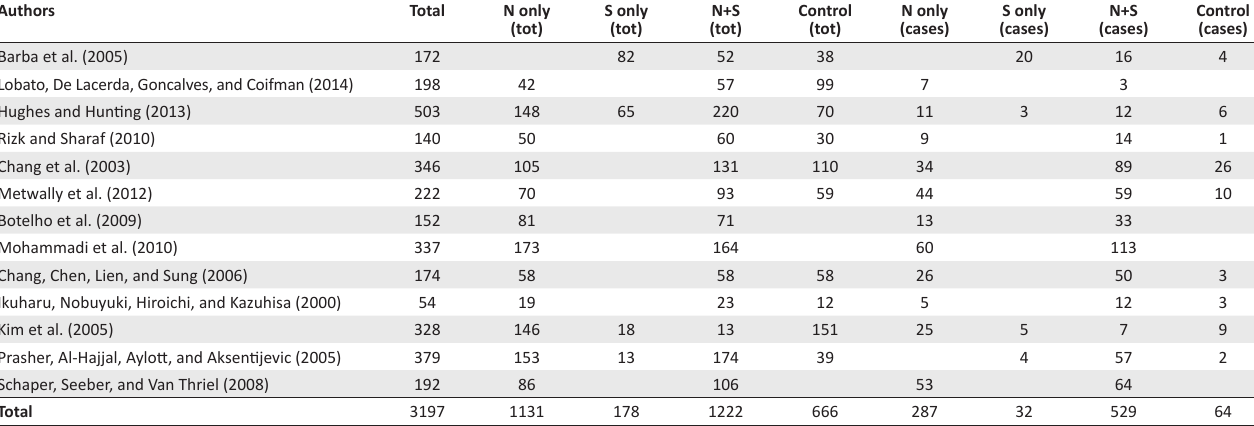
TABLE 1: Description of number of participants in